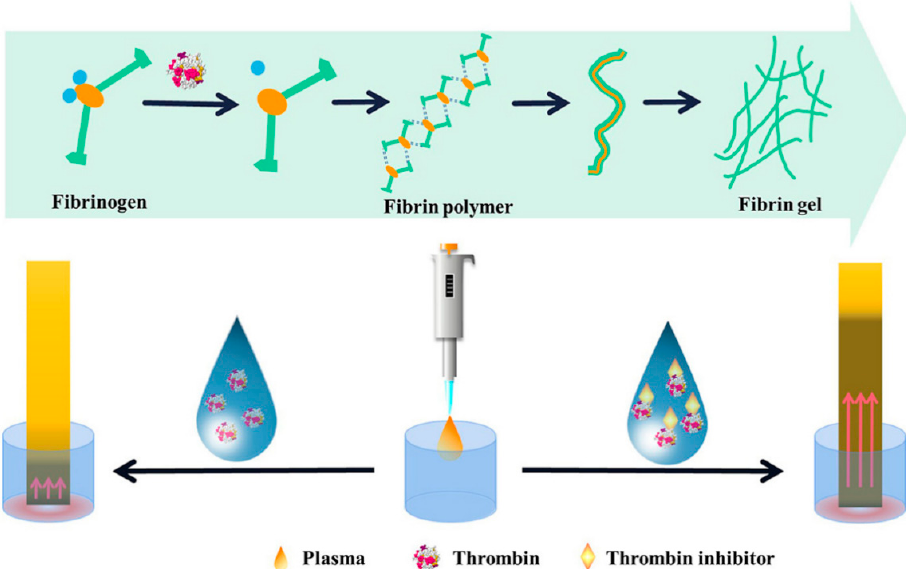
Figure 13. Schematic illustration of paper-based sensing for the detection of thrombin and its inhibitor via monitoring the viscosity change of the amylopectin solution. Reproduced with permission from Chengliang Han, Analytica Chimica Acta; published by Elsevier, 2022.